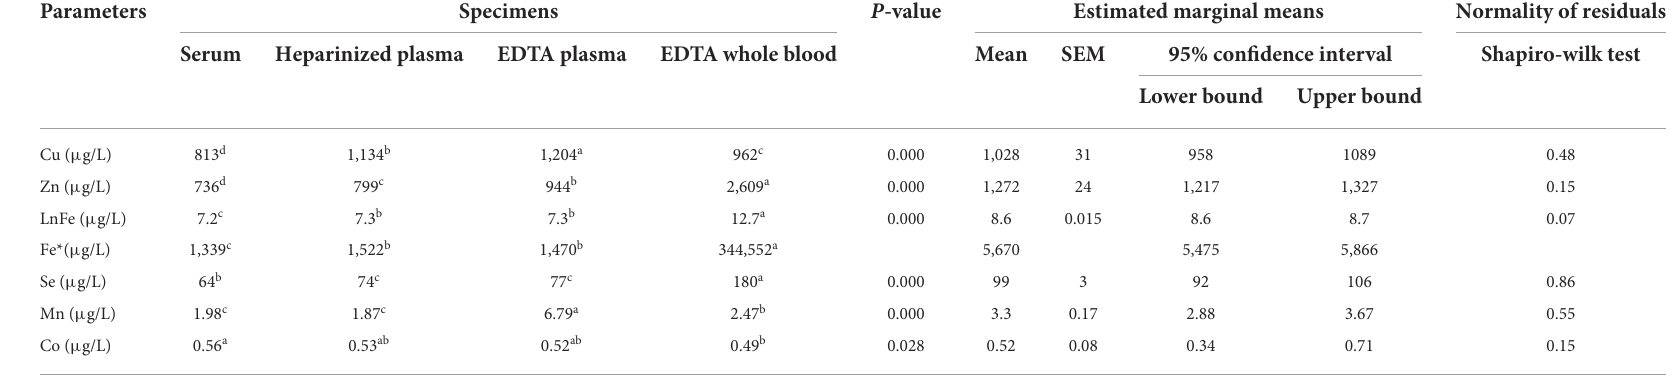
TABLE 5 Linear mixed model of essential trace element in different blood specimens of dairy cows ( n =